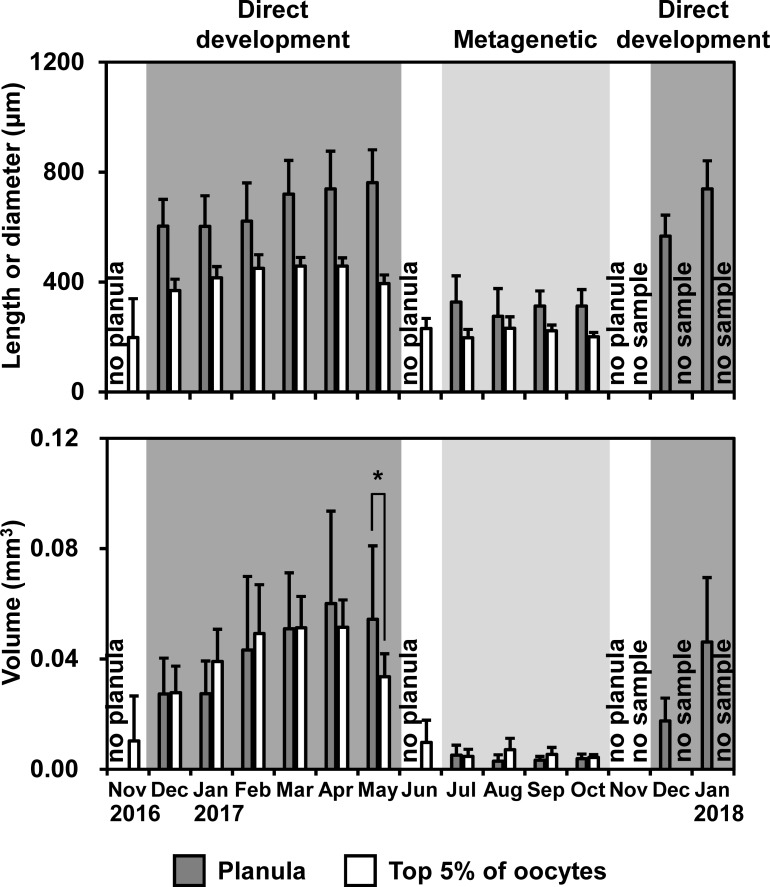
Temporal variations in the length of the major axis of the planulae, diameter of the top 5% of oocytes, and volume of the planulae and top 5% of oocytes.Bars and error bars are mean values and SD. * in the bottom figure indicates a significant difference (P < 0.05). No planula indicates that no females bore planulae. Dark and light shades indicate the direct-development and metagenetic periods, respectively.